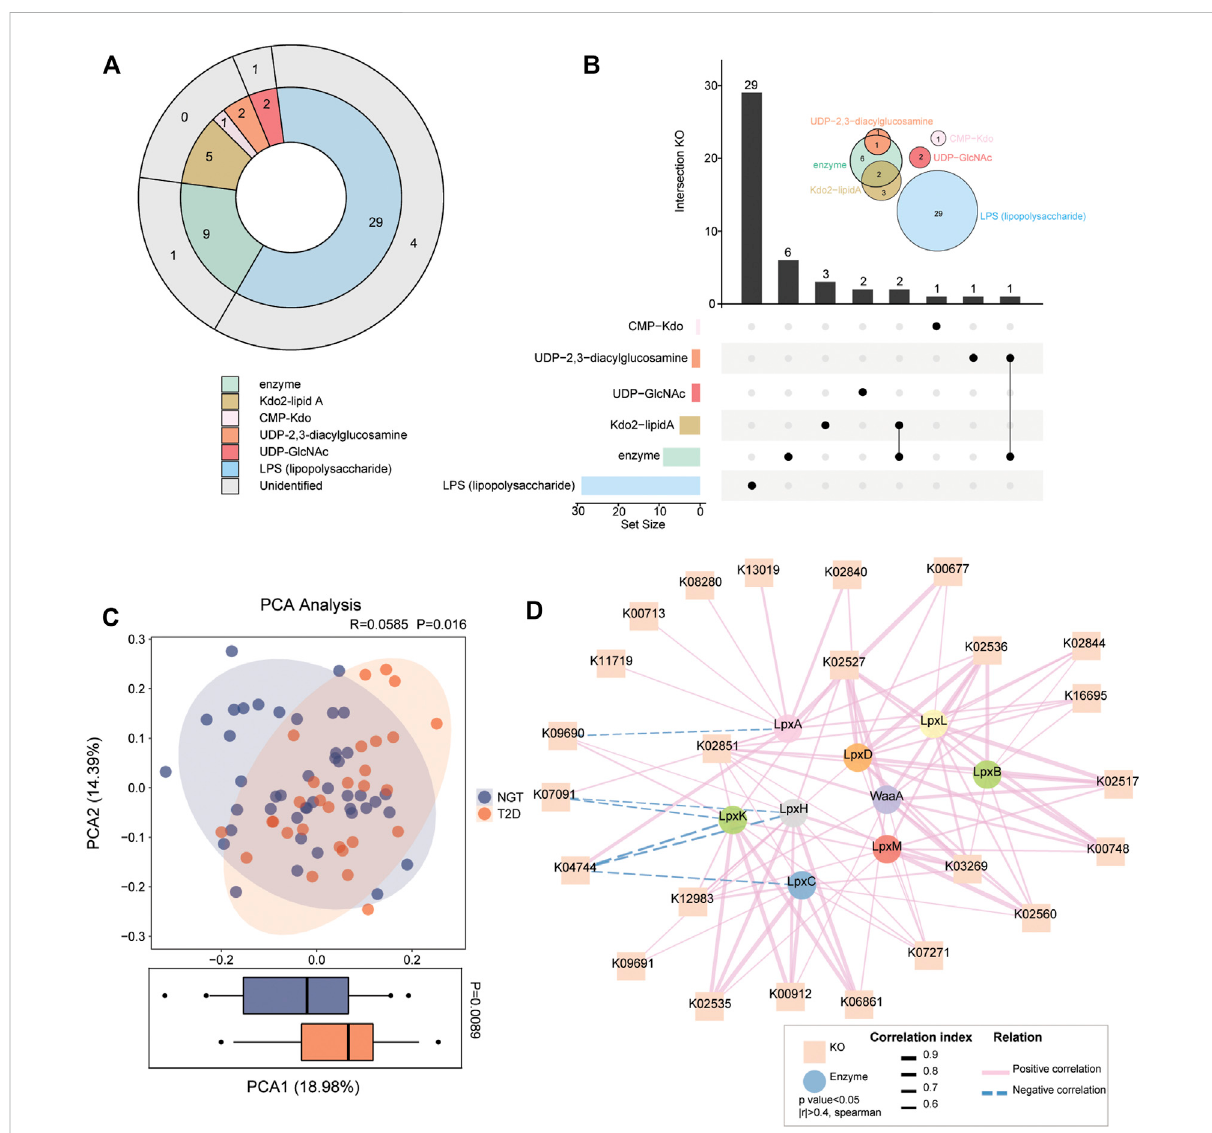
FIGURE 2 Gut microbial KOs implicated in LPS biosynthesis in individuals with NGT and patients with T2D. (A) KOs involved in synthetic progress and transformation pathways for LPS biosynthesis were identi fi ed through related compounds and enzymes. Different compounds or enzymes are shown in different colors. The outer circle in gray indicates the six KOs not detected in the present cohort. (B) UpSet plot and Venn diagram analysis showed the coexisting KO distributions in LPS-biosynthesis-related compounds and enzymes. The bar plot at the bottom left shows the number of KOs implicated in each compound and enzyme. The dot and line at the bottom right represent the unique and shared KO intersection by different compounds and enzymes, respectively. The number of speci fi c KOs and shared KO intersections are shown in the black histogram above. Venn diagrams at the upper right show the number of annotated KOs involved in LPS-biosynthesis-related compounds and enzymes. One KO was shared by the LPS-biosynthesis-related enzymes and UDP-2,3-diacylglycosamine, and two KOs are shared by Kdo2-lipidA and enzymes. (C) PCA analysisbasedonthe45annotatedKOsacrossindividualswithNGTandpatientswithT2D. p =0.016betweengroups,ANOSIMtest.Thedistribution of patients with T2D according to KOs was signi fi cantly different from that in NGT at the PCA1 axis ( p = 0.0089, Wilcoxon rank-sum test). (D) Correlation network re fl ectingtheinteractionbetweenLPS-biosynthesis-relatedenzymes(circle)andKOs(square).Spearmencorrelationanalysis,| r | > 0.4, p < 0.05.Linesconnectingnodesindicatepositive(solidlinesinred)ornegative(dottedlinesinblue)correlations,andthethicknessoflinesis proportional to the correlation coef fi cients. T2D, type 2 diabetes; NGT, normal glucose